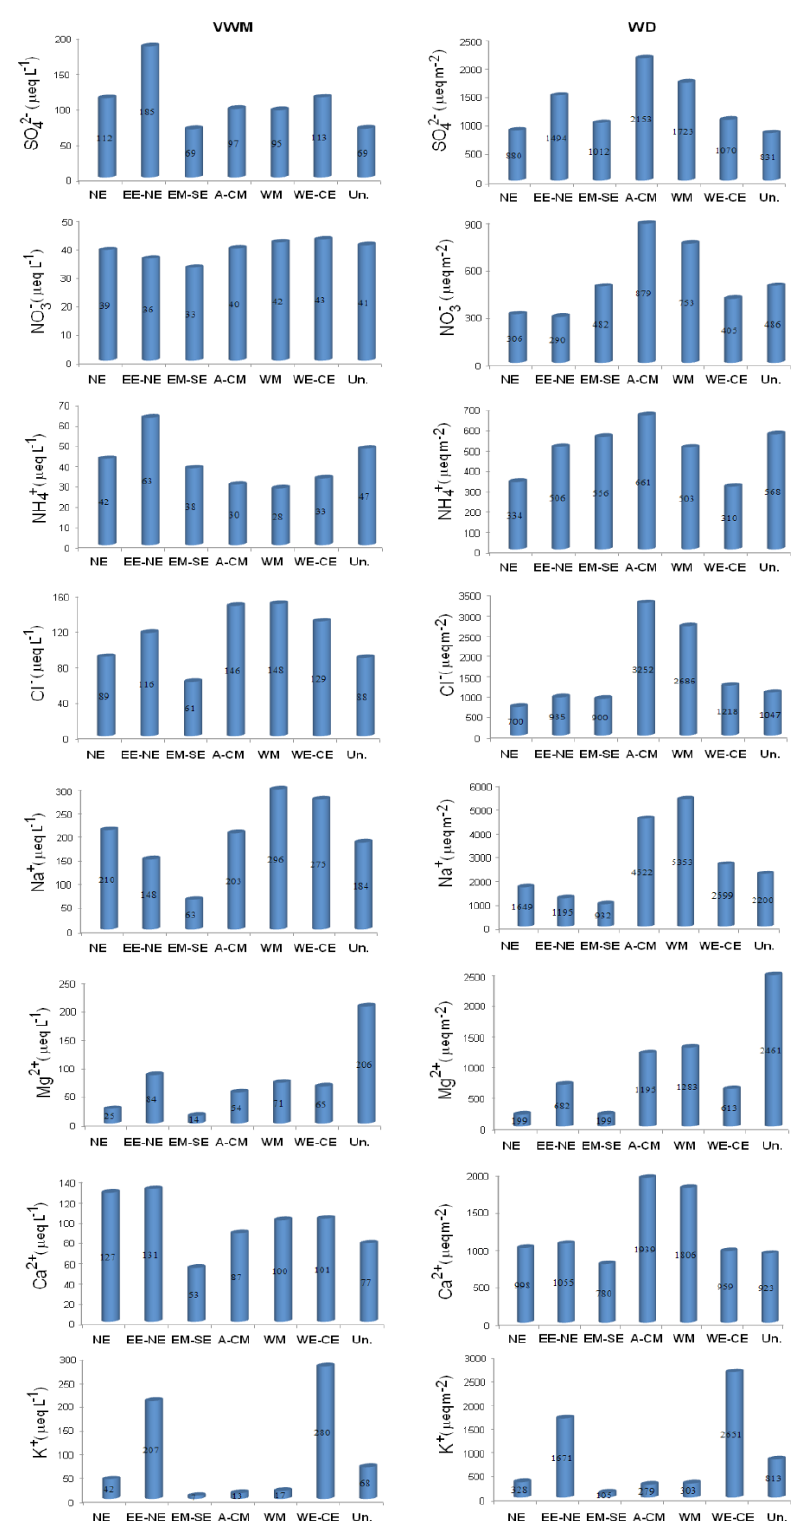
Figure 4. Average Volume-Weighted Mean and total Wet Deposition divided in six categories, plus undefined for the total period of investigation (1995 –